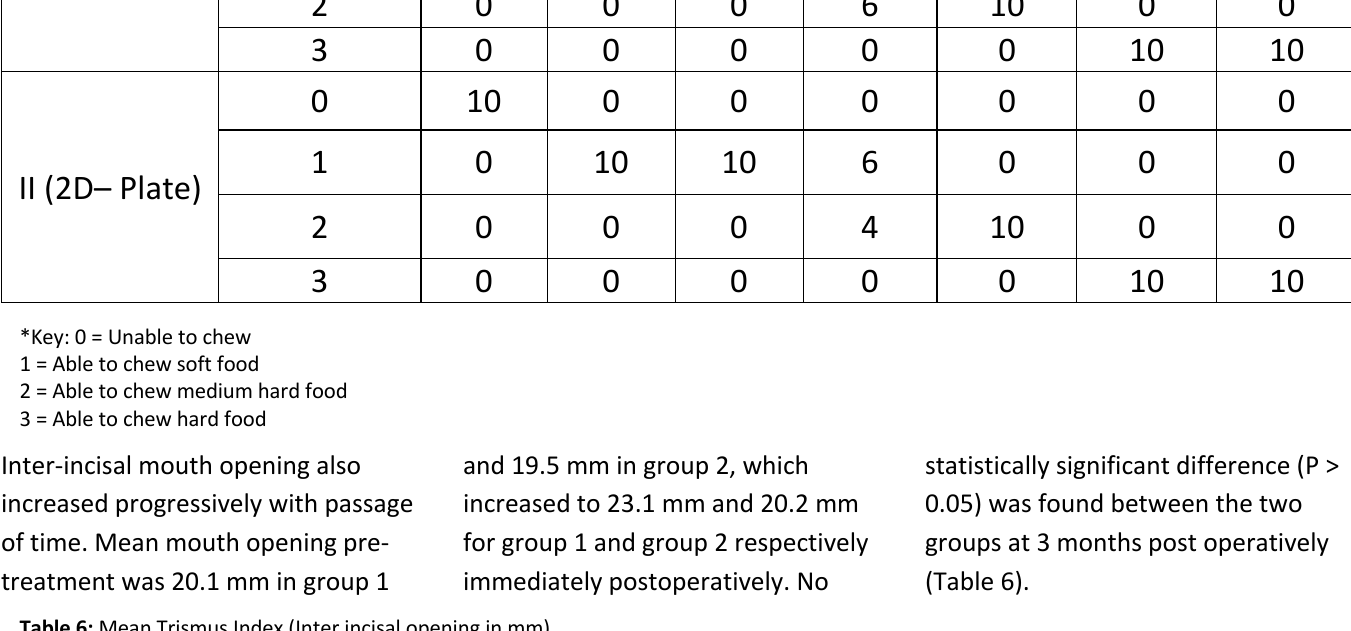
statistically significant difference (P > 0.05) was found between the two groups at 3 months post operatively (Table 6).